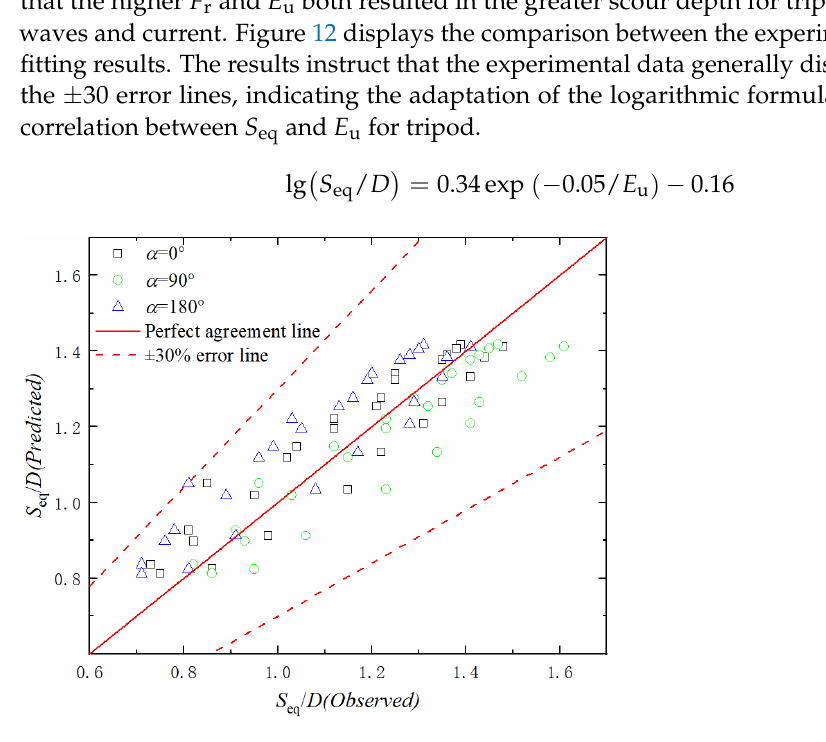
Figure 12. Comparison of experimental data and predicted values by Equation (15).